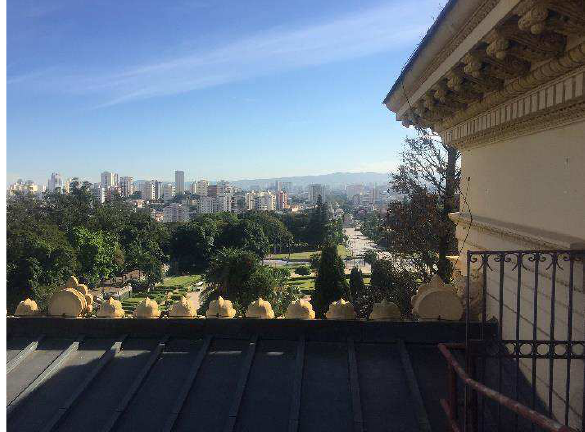
Figure 1. Museu do Ipiranga – USP main façade. View of the central projecting pronaos from the monumental gardens overlooking the main building